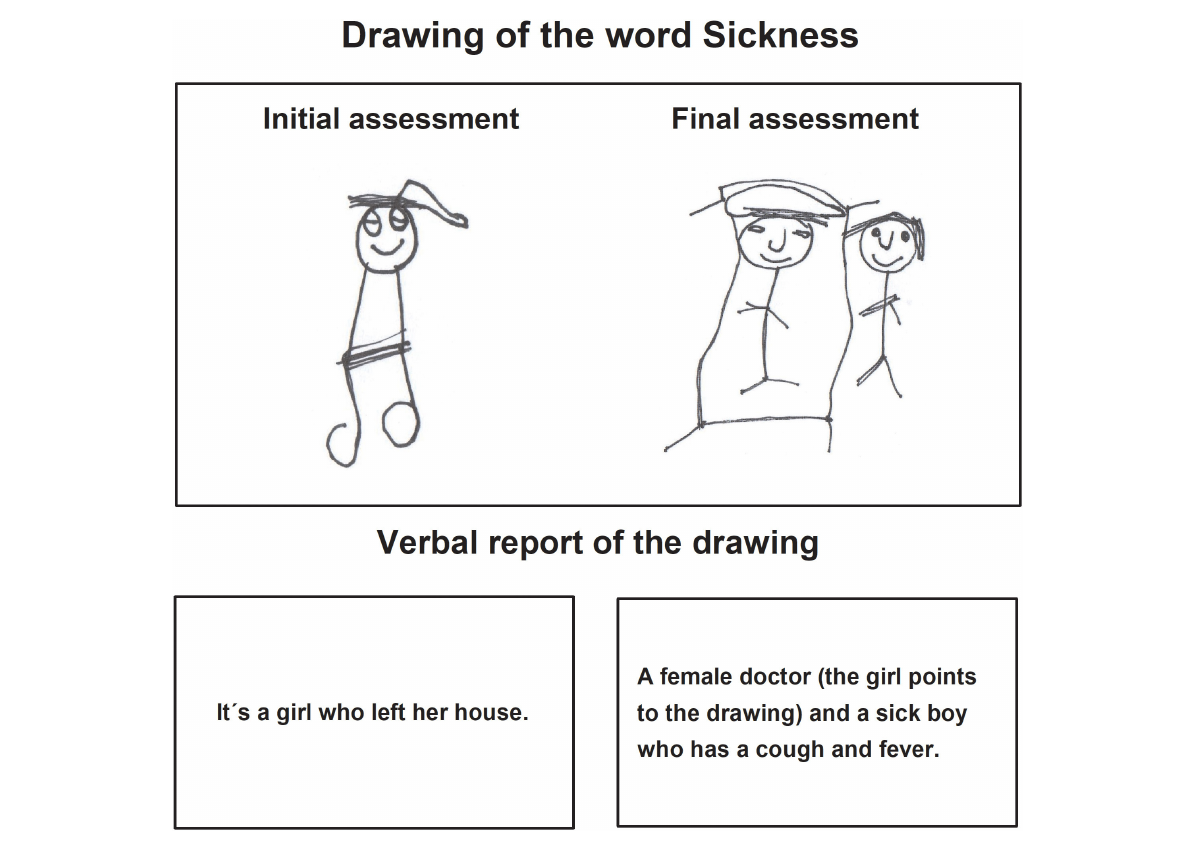
FIGURE2 Child B drawing in the pictogram task during the initial and final